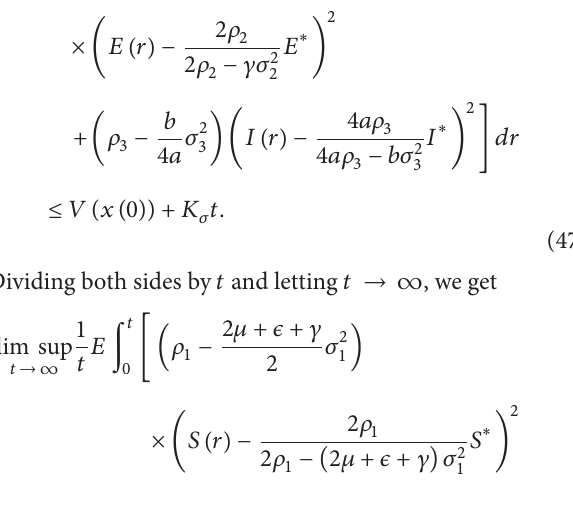
= 0 , 𝜎 = 0.1 , and 𝜎 = 0.2 1 2 3